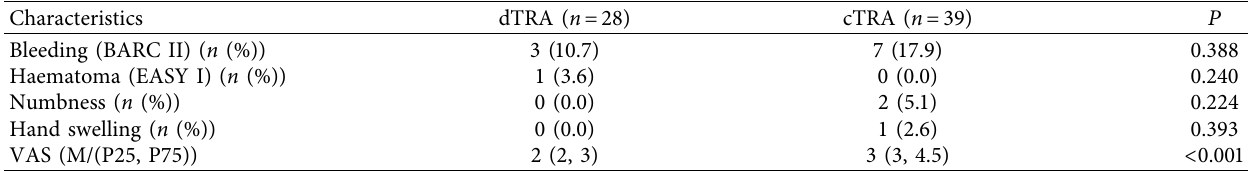
Table 3: Comparison of the safety between the two groups.